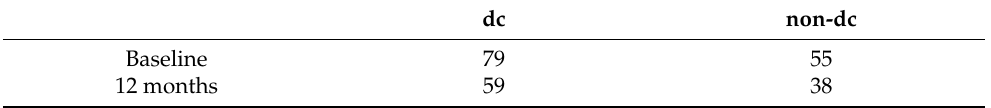
Table 2. Patient with diffuse cutaneous involvement (dc) 1